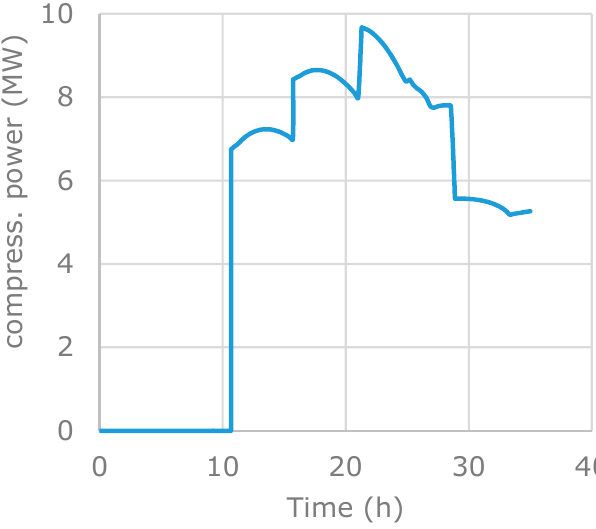
Figure 11. Compressor power (adiabatic loading).